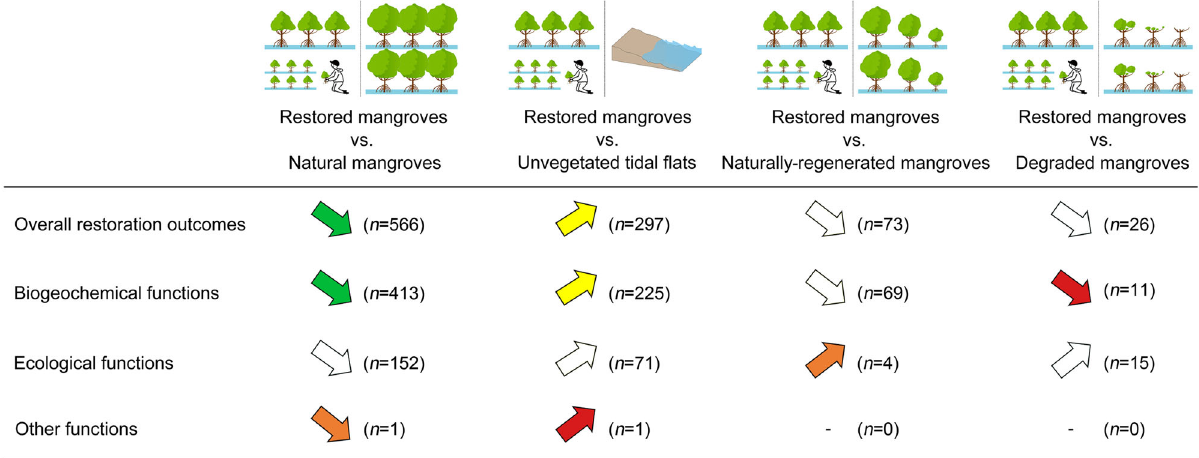
Fig. 5 Summary of mangrove restoration outcomes. All comparisons are between restored mangroves and the respective land use indicated at the top of the fi gure. Upward and downward arrows denote positive and negative effects respectively. Colours denote the interpretive benchmark of effect size values 99 . Green: small effects (absolute value of 0 – 0.30); yellow: medium effects (absolute value 0.30 – 0.60); orange: large effects (absolute value 0.60 – 0.90); red: very large effects (absolute value >0.90). For these coloured arrows the 95% CIs did not intersect with zero (see Methods section). Arrows in white indicate there is no major difference between restored mangroves and paired reference sites (i.e. 95% CIs intersected with zero). The numbers in parentheses indicate the number of observations ( n ). The crossbar ( − ) denotes that there were no applicable results for the speci fi c function. Source data are provided as a Source Data fi le.